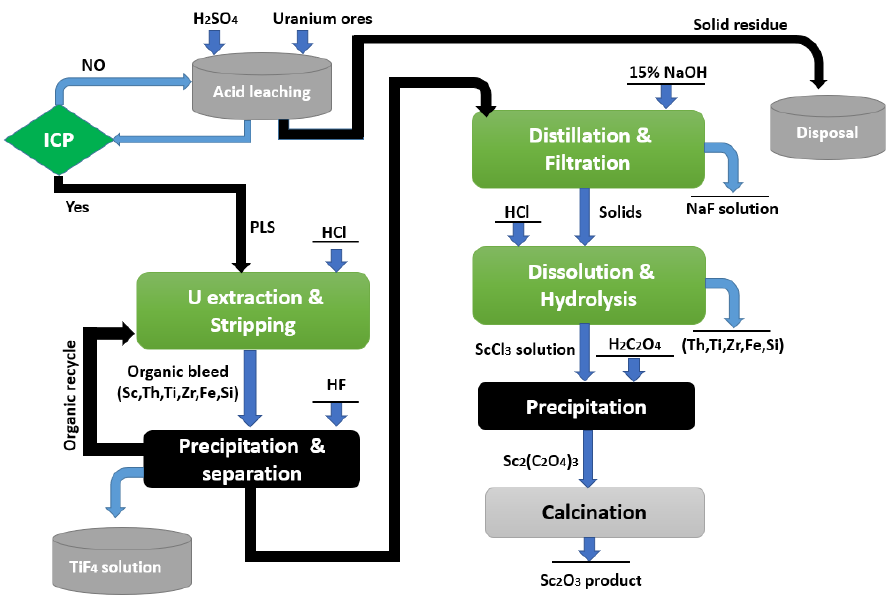
Figure 8. Scandium recovery from uranium ores, adapted from [104].